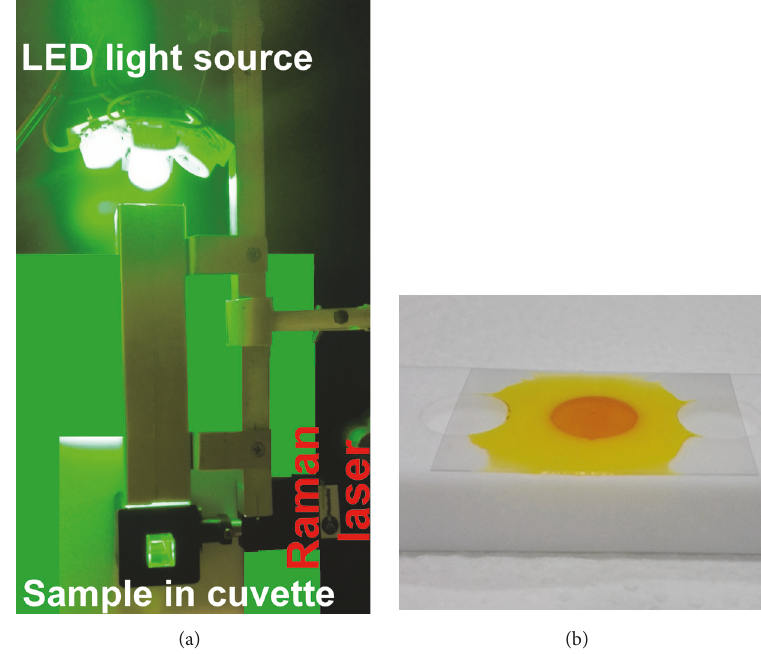
Figure 1: Experimental layout for Raman spectroscopy (a) and the laminated Teflon mold used for preparing the resins